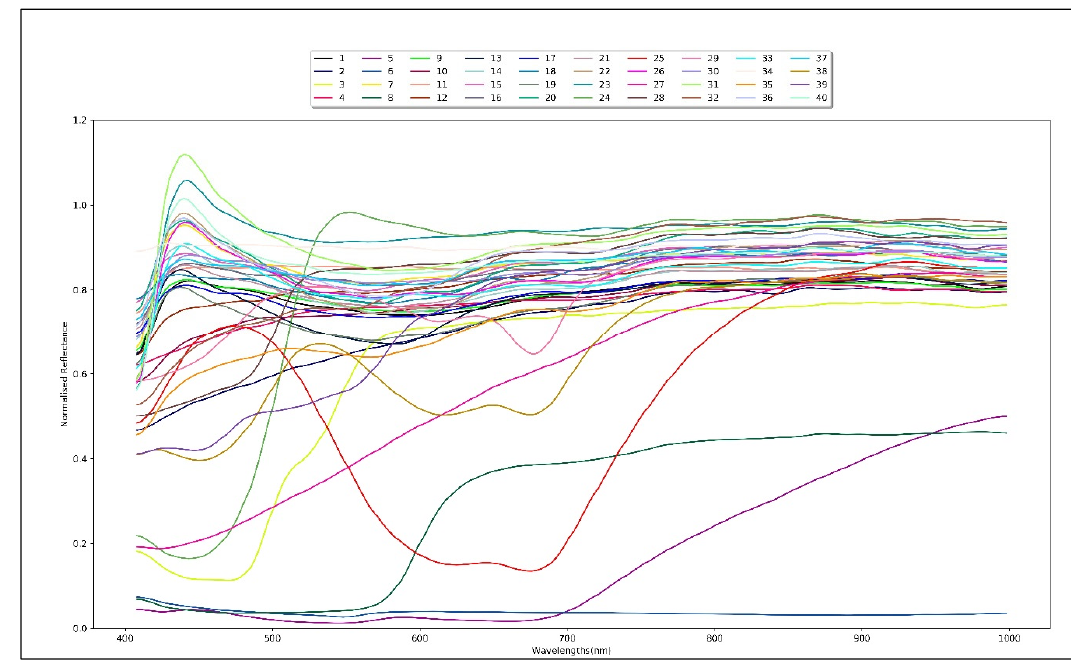
Figure 5. Average normalized reflectance spectrum of 40 paper samples.